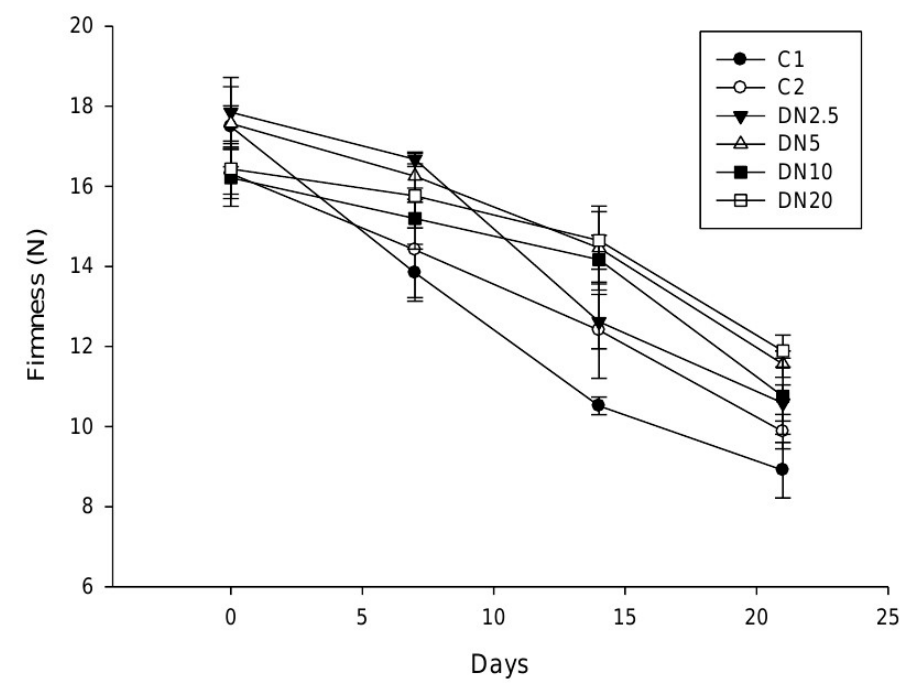
Figure 1. Percentage of weight loss in tomato fruits coated with nanoemulsion during storage at 6 °C.